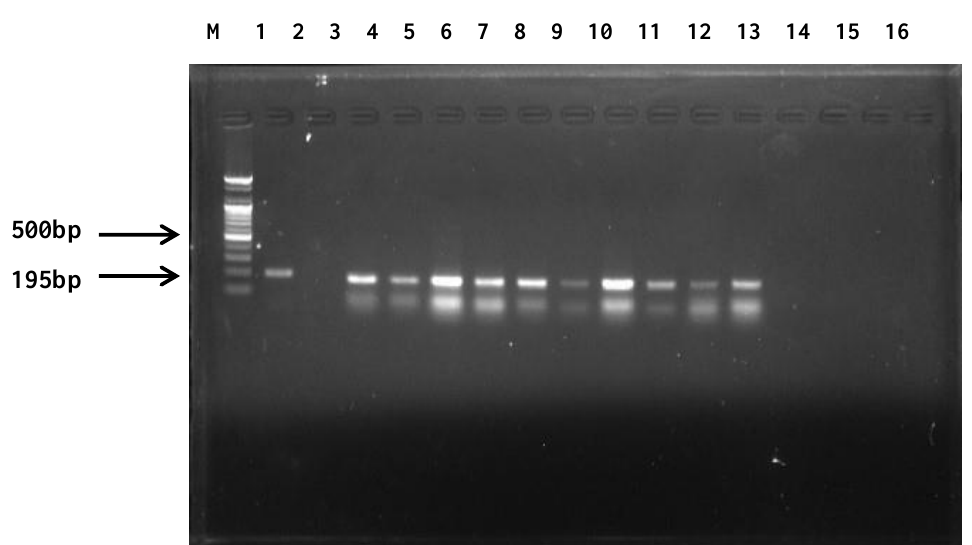
Figure 2. PCR amplification of the beta -toxin ( cpb ) from 10 C. perfringens isolates. Lane M: molecular size marker (100bp DNA ladder, Bioneer, Korea); Lane 1: standard strain (ATCC 3626) cpb gene; Lane 2, 13 to 16; negative control; Lane 3 to 12: cpb genes detected from 10 C. perfringens isolates.